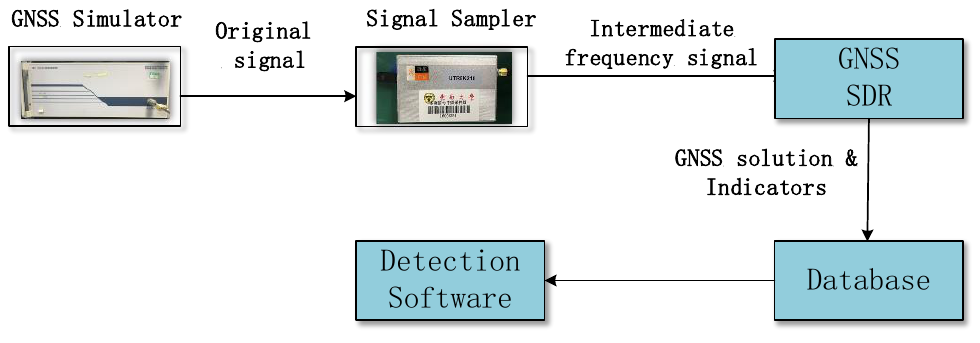
Figure 1. The meaconing system.